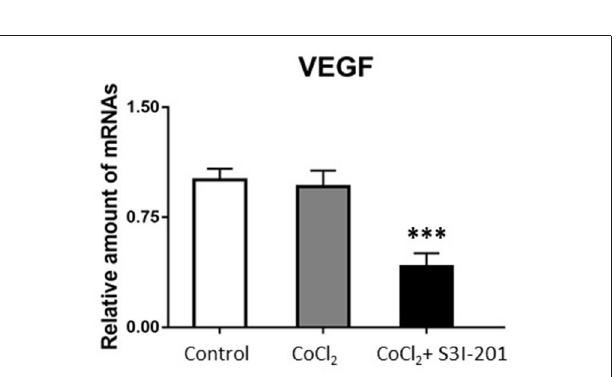
FIGURE 5 | PCR result showed VEGF mRNA expression in retinal cells treated with 250 µ mol/L CoCl 2 and S3I-201 (*** p <